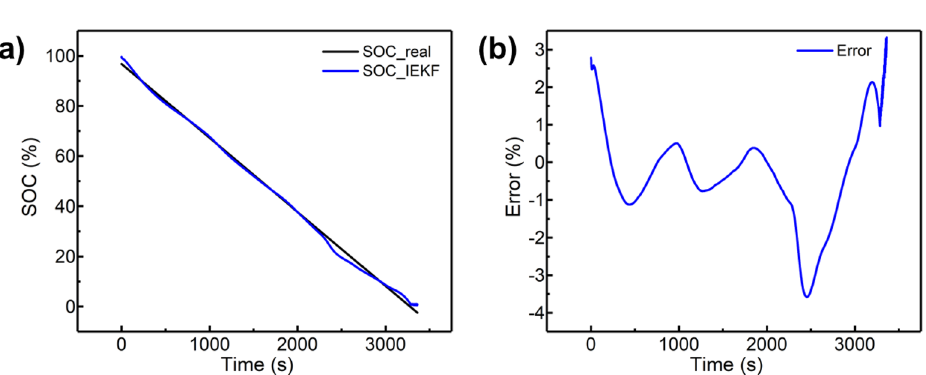
Figure 8. Result of SOC estimation under – 10 ℃ . (a) The SOC estimation and max error is under 3%; (b) error analysis.